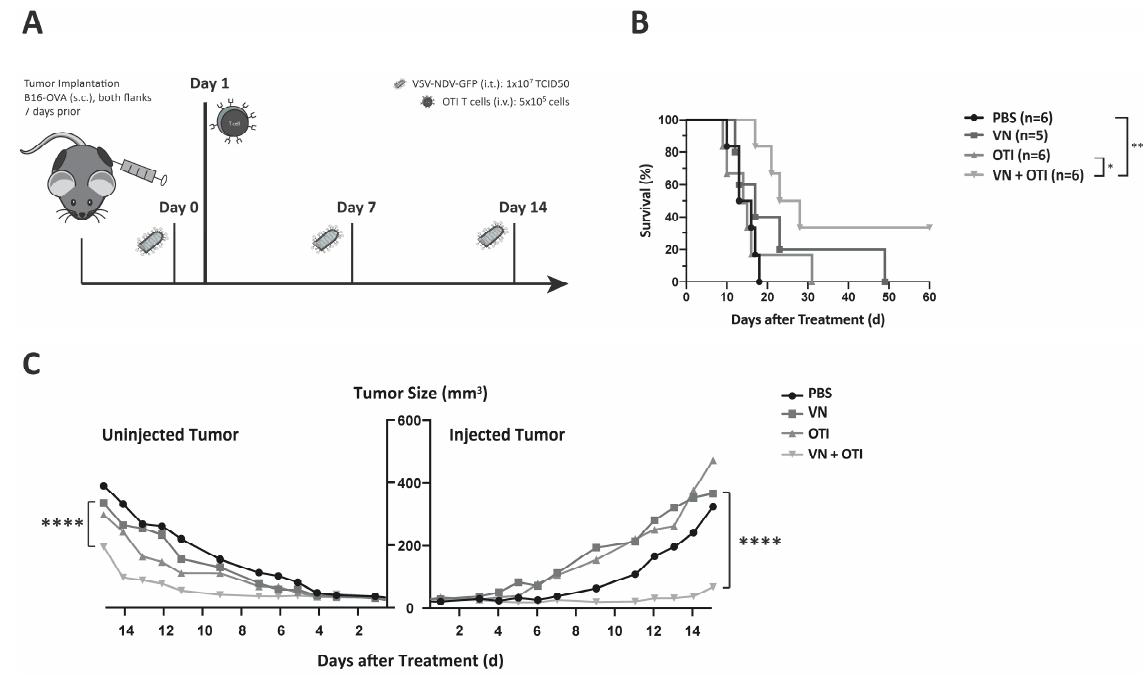
Figure 5. Benefits of combination therapy are highlighted in a modified dosing scheme. ( A ) Experimental set-up of the adapted survival experiment. C57BL6/J mice were implanted with 2.4 × 10 5 (injected tumor) and 1.2 × 10 5 (uninjected tumor) B16-OVA cells subcutaneously on contralateral flanks. One week later, mice were randomly distributed into treatment groups ( n = 5–6) and injected intratumorally with VSV-NDV at a dose of 10 7 TCID50 or PBS in an equal volume of 50 µ L on day 0, followed by an intravenous OTI T cell injection (5.5 × 10 6 ) on day 1 for combination treatment or OTI monotherapy. Intratumoral virus or PBS injections were repeated on day 7 and 14. ( B ) Survival of the different treatment groups was monitored and plotted in a Kaplan–Meier curve. Statistical significance was determined by log-rank test (* p < 0.05, ** p < 0.01). ( C ) Tumor growth was monitored by caliper measurements of tumor width and length. The volume was calculated according to the modified ellipsoid formula: Tumor volume = 1/2(length × width 2 ). Mean tumor volume was plotted up to day 14 for uninjected and injected tumors according to the indicated treatment groups. Statistical significance was determined by student’s t-test (**** p <